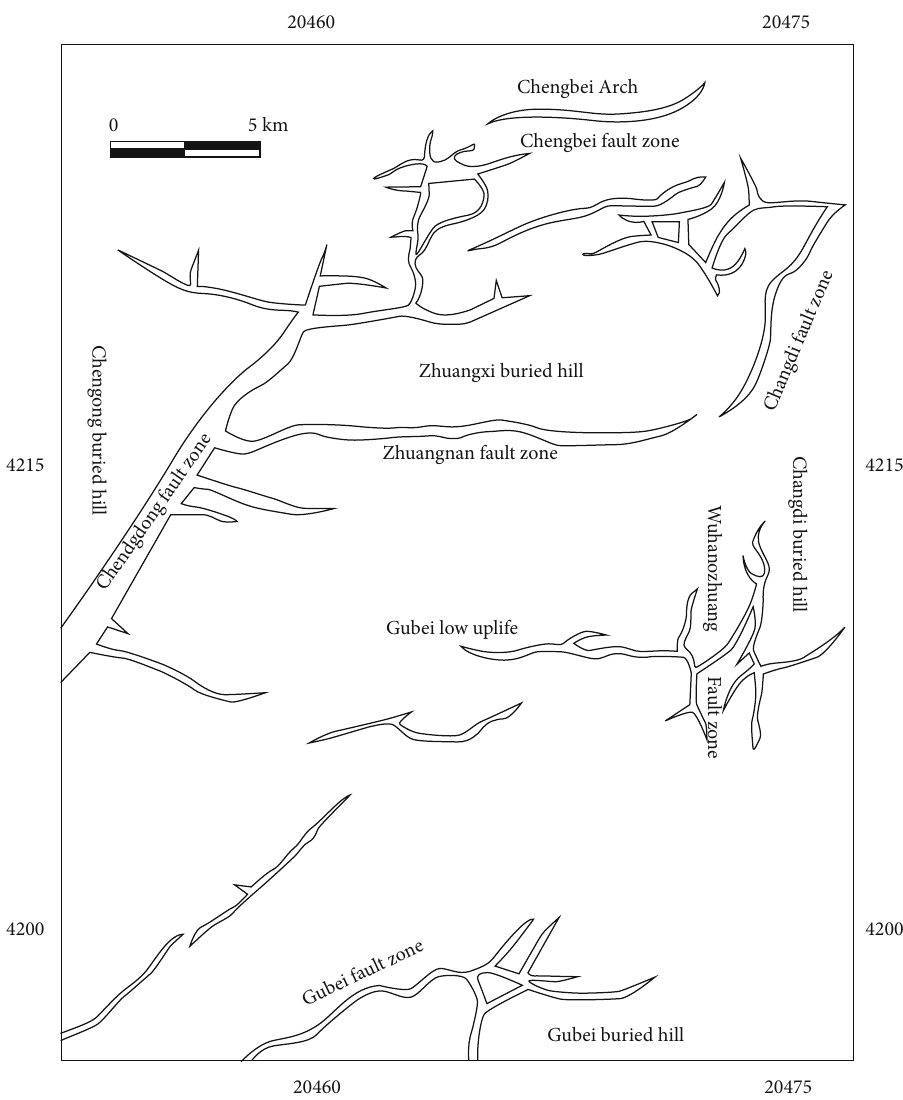
Figure 1: Structural position of Zhuangnan fault